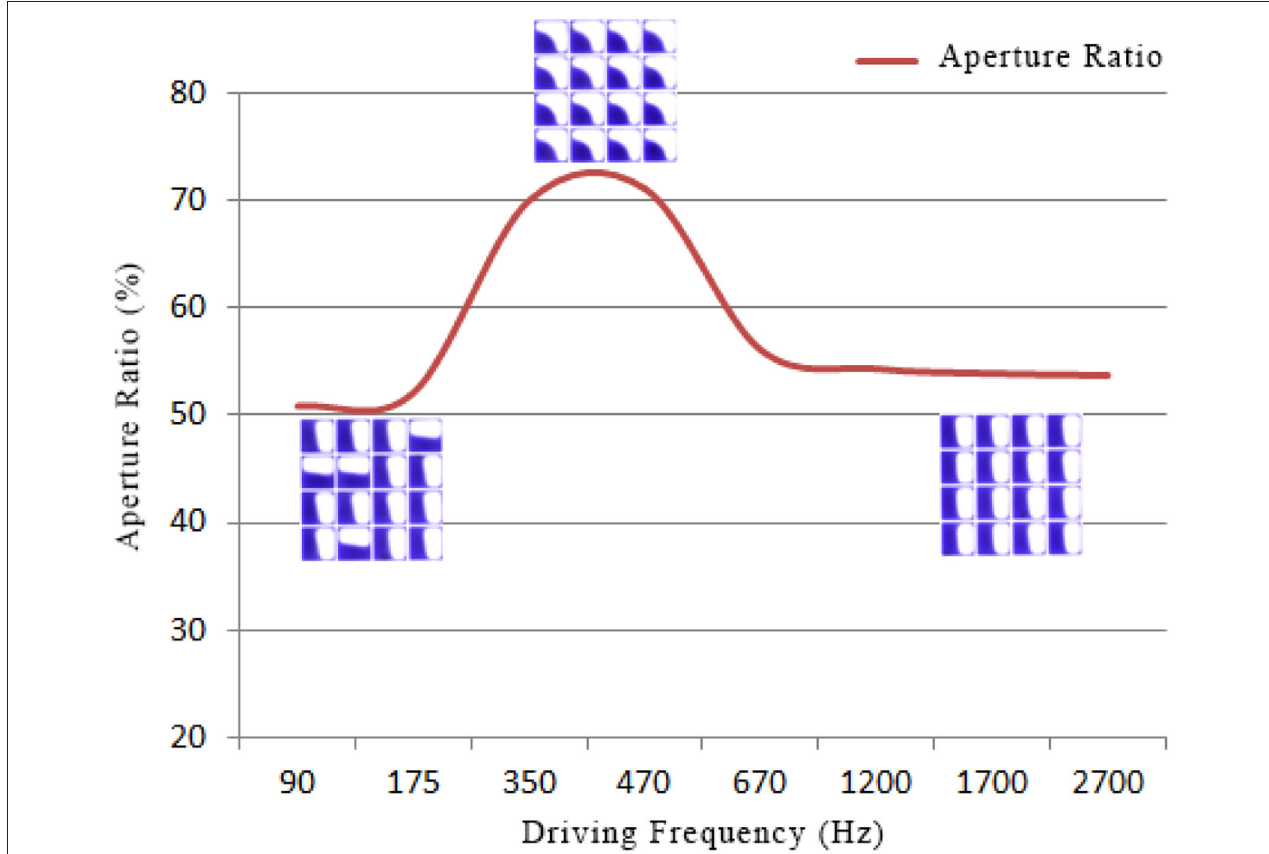
FIGURE 7 | The EWD was driven by a 30V AC driving voltage, the aperture ratio changed when the frequency was increased from 90 to 2,700Hz. When the frequency was 350–500Hz, pixels were fully opened.